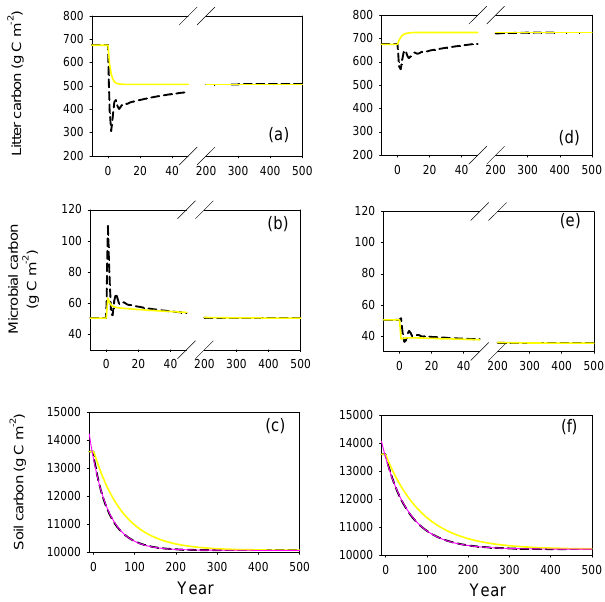
Fig. 9. Responses of different carbon pools to a 5 ◦ C warming above Figure 9. Responses of different carbon pools to a 5 o C warming above 15 o C at time t =0 of the 818 15 ◦ C at time t = 0 of the nonlinear (dashed black curves) or lin- nonlinear (dashed black curves) or linear (yellow curves) versions of the three-pool models. Panels 819 ear (yellow curves) versions of the three-pool models. Panels (a–c) (a)- (c) for an instant acclimation to warming with a microbial growth efficiency of 0.39 as calculated 820 for an instant acclimation to warming with a microbial growth ef- for a soil temperature at 15 o C and the panels (d)-(f) for no acclimation to warming with a microbial 821 ficiency of 0.39 as calculated for a soil temperature of 15 ◦ C, and growth efficiency of 0.31 as calculated for a soil temperature of 20 o C.  =0.02 for all simulations 822 the panels (d–f) for no acclimation to warming with a microbial growth efficiency of 0.31 as calculated for a soil temperature of here. The pink curves on panels (c) and (f) are the best fitted regressions to the simulation by the 823 20 ◦ C. α = 0 . 02 for all simulations here. The pink curves on panels nonlinear model (dashed black curves). 824 (c) and (f) are the best fitted regressions to the simulation by the nonlinear model (dashed black